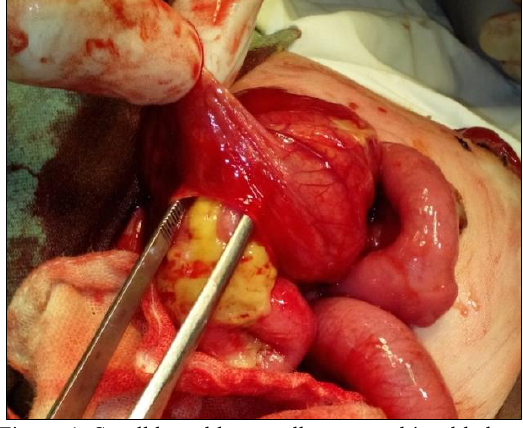
Figure 1: Small bowel loops adherent and jumbled up below the stomach and greater omentum adherent simu- lating as a true